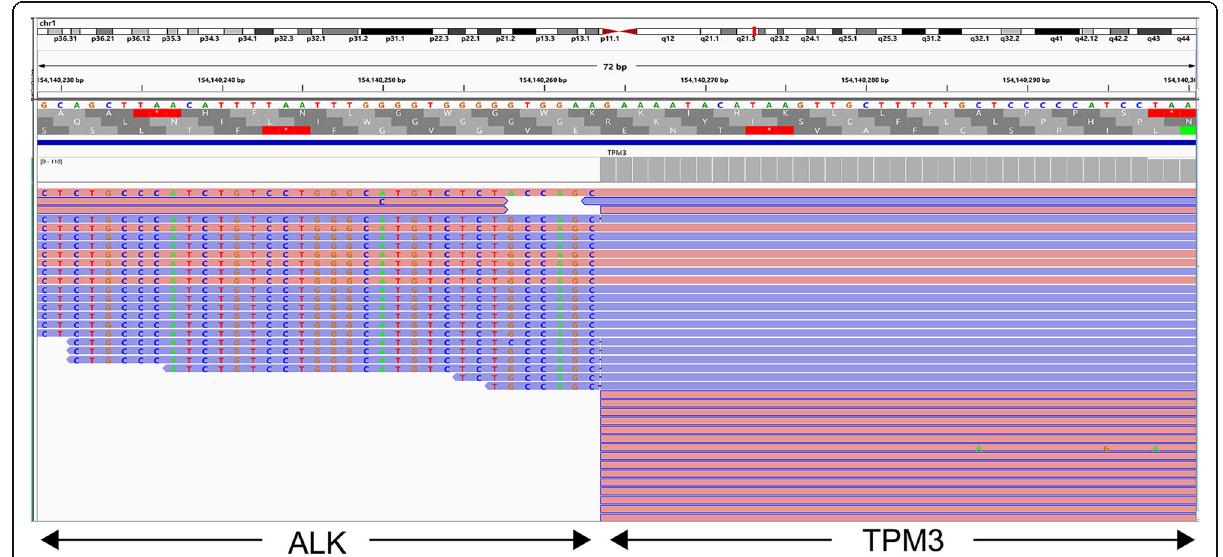
Fig. 2 NGS assay detected the fusion of ALK (donor end: chr2: 29447792) and TPM3 (acceptor start: chr1: 154140265) in the tumor visualized in the Integrative Genomics Viewer (IGV, www.broadinstitute.org/igv, human reference genome hg19). The fusion gene